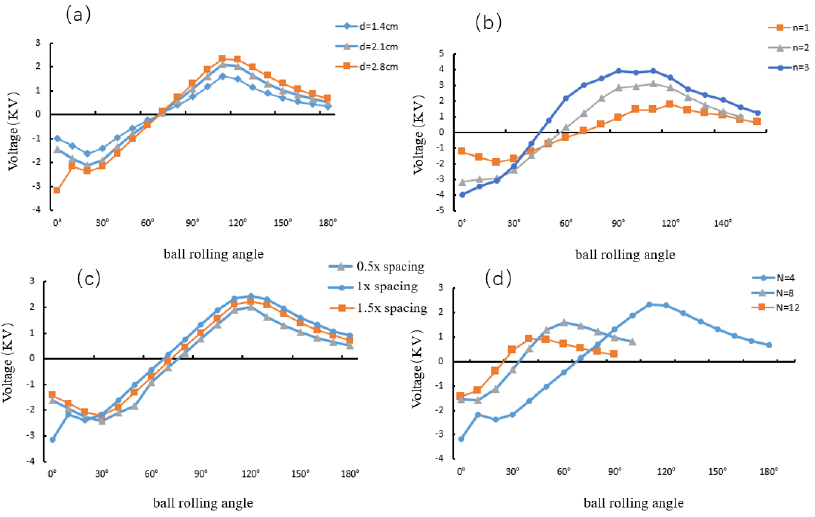
Figure 3. ( a ) Open-circuit voltage for different nylon ball diameters. ( b ) Open-circuit voltage for different quantities of nylon balls. ( c ) Open-circuit voltage for different electrode spacings. ( d ) Open- circuit voltage for different amounts of